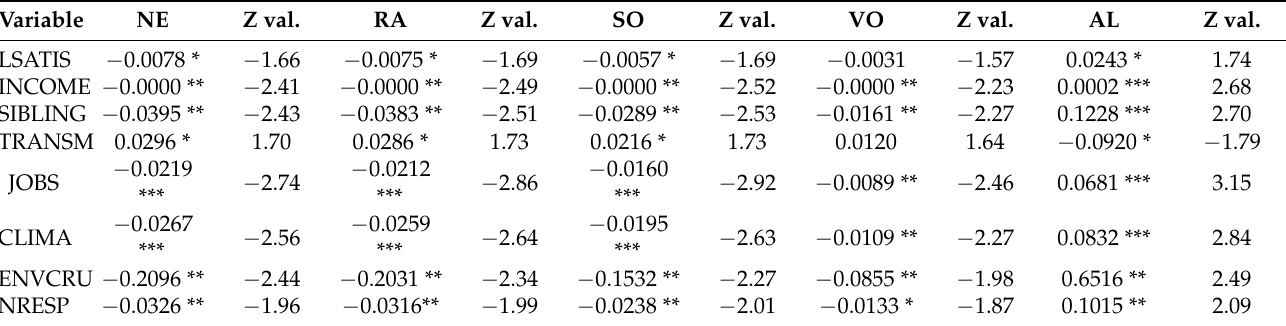
Table 5. Average marginal effects for recycling glass (low-cost PEB).